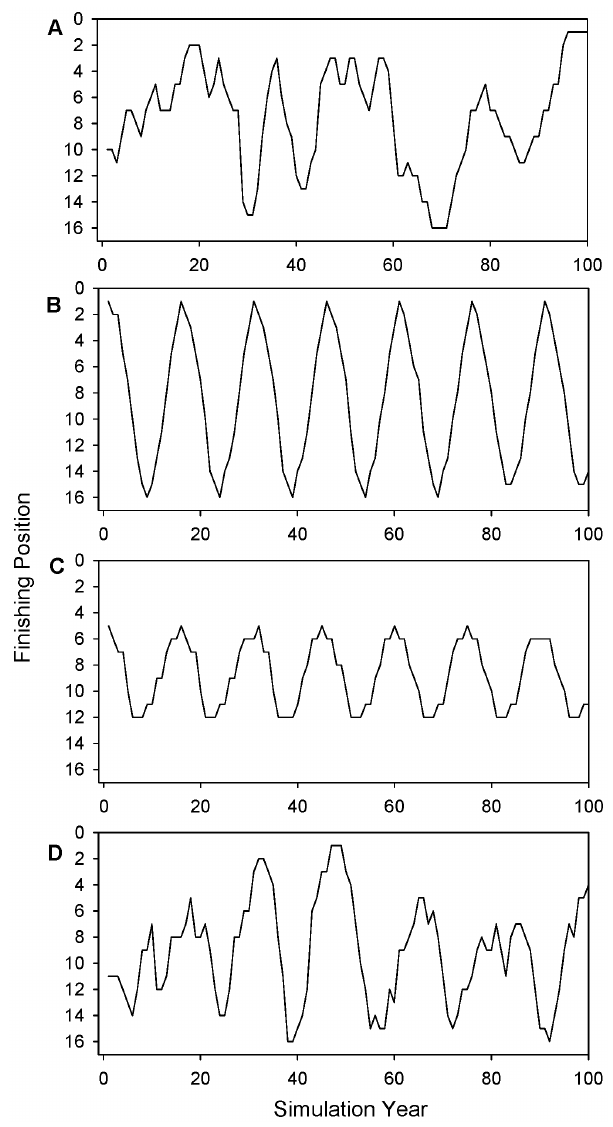
Figure 3. Finishing position of one of 16 teams in a league simulated over 100 years, for differing simulation scenarios: (a) random lottery draft system, (b) and (c) examples from a reverse-order draft system with no uncertainty regarding the ability of players drafted, s min ~ s max ~ 0 , and (d) reverse-order draft system with draft choice uncertainty s min ~ 0 : 05 and s min ~ 0 : 5 . mance of approximately 5.5 years from debut, m u ~ ln(12) , to an older-aged peak of approximately 12 years from debut, ~ ln (24) , the proportion of premierships won by a single m u tanking team increases marginally ( W won ~ 0 : 093 to 0 : 106 ), and the evenness of the competition decreases ( CV ~ 0 : 038 to 0 : 057 ).